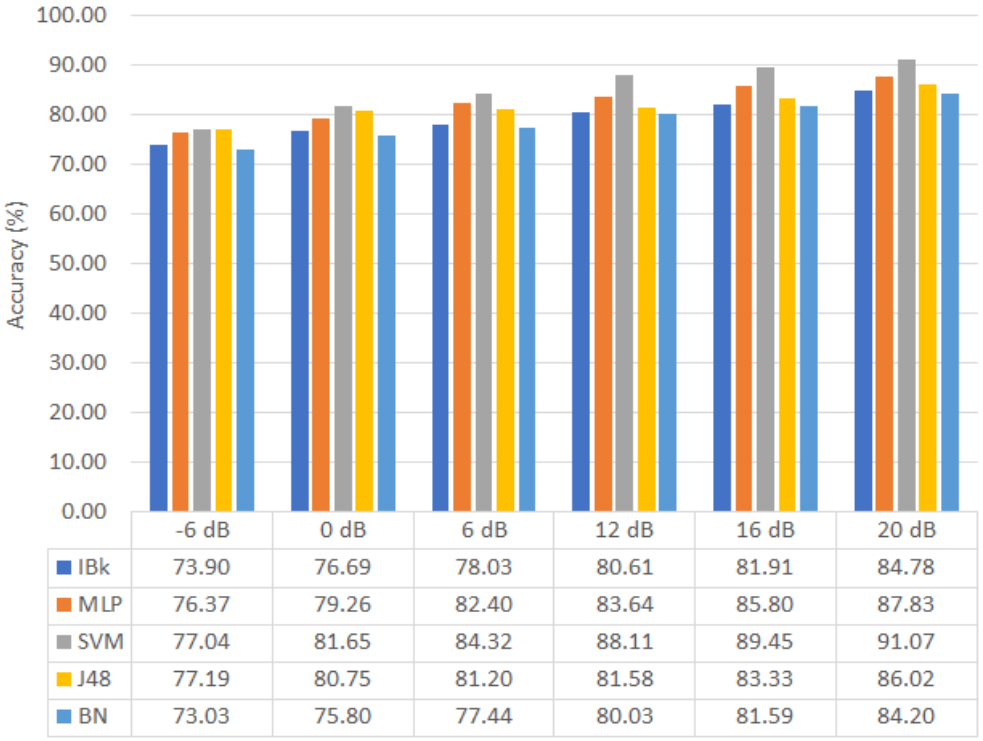
Figure 3. The accuracy (in percentages) of the acoustic wood logging classification for various ratios of signal-to-noise and different classification algorithms.